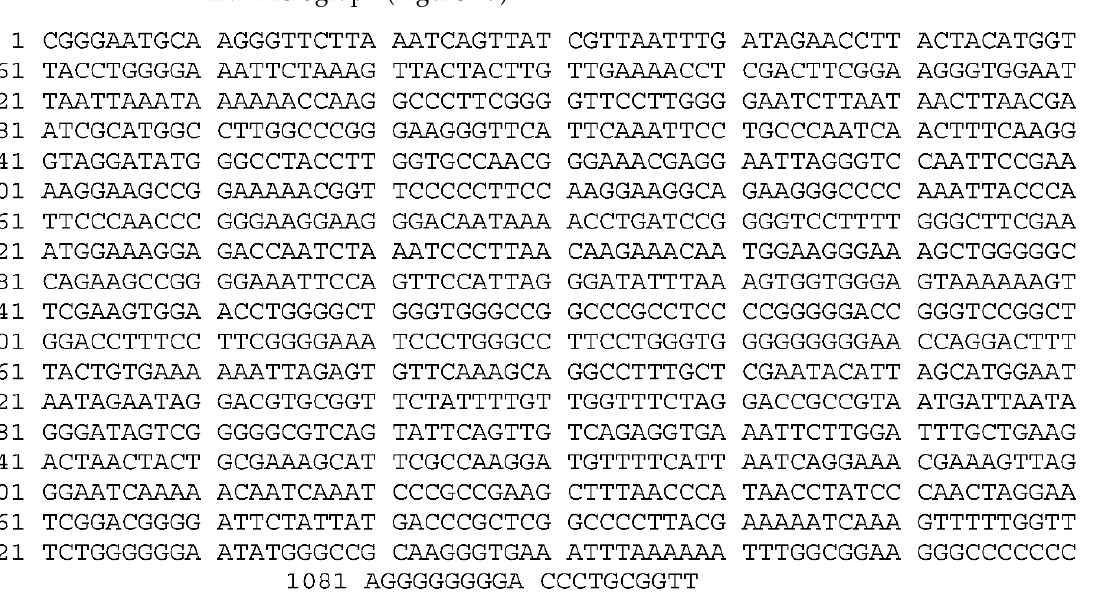
Figure 1. 1100 bp long 18S rRNA gene sequence of the fungal isolate submitted to the NCBI (Accession number OL636020). The BLAST analysis of the above sequence shows maximum similarity with Aspergillus niger strain.